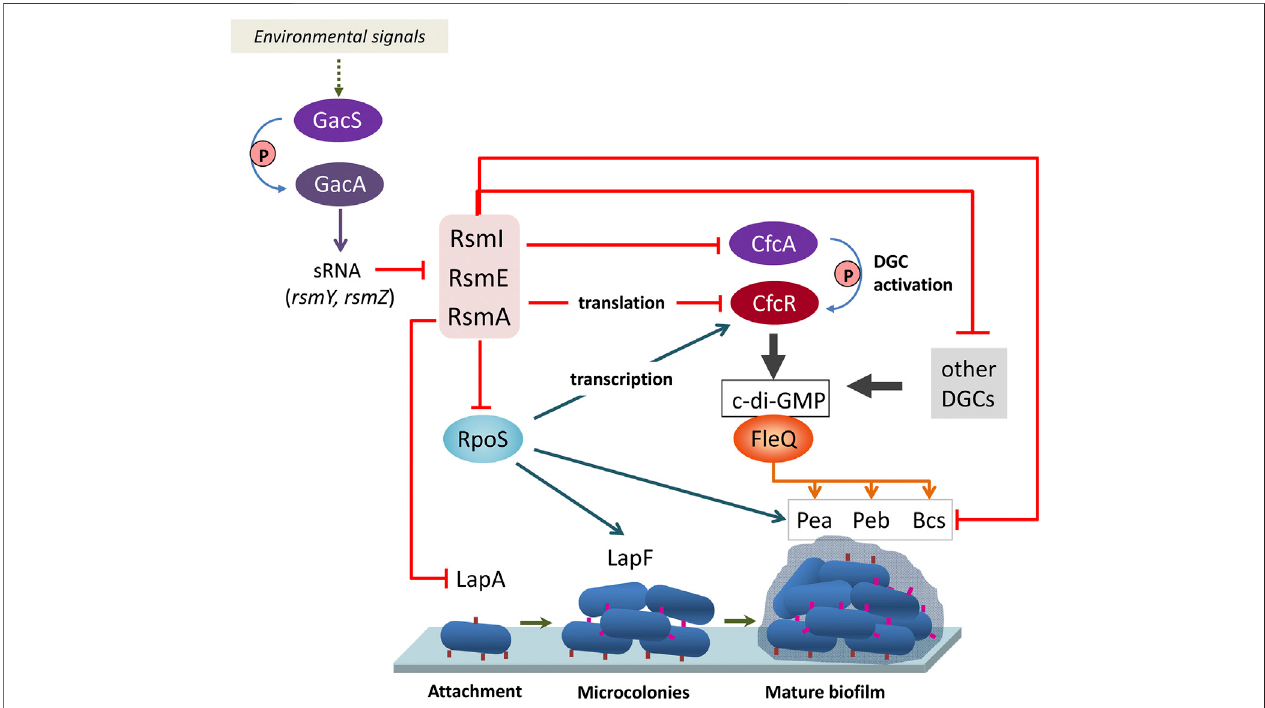
FIGURE 4 | Schematic view of the connection between the Gac/Rsm signaling cascade with bio fi lm formation through c-di-GMP turnover, adhesins and exopolysaccharides. The Rsm proteins exert a complex regulation on the response regulator with DGC activity CfcR, at the transcriptional (via RpoS), translational (via directbinding),andpost-translational(viathehistidinekinaseCfcA,requiredforphosphorylationofCfcR)levels.Directin fl uenceofRsmproteinsonstructuralelementsof the bio fi lm matrix, and indirect in fl uence via RpoS and the c-di-GMP associated regulator FleQ are also depicted. Blue arrows indicate positive regulation and red lines negative